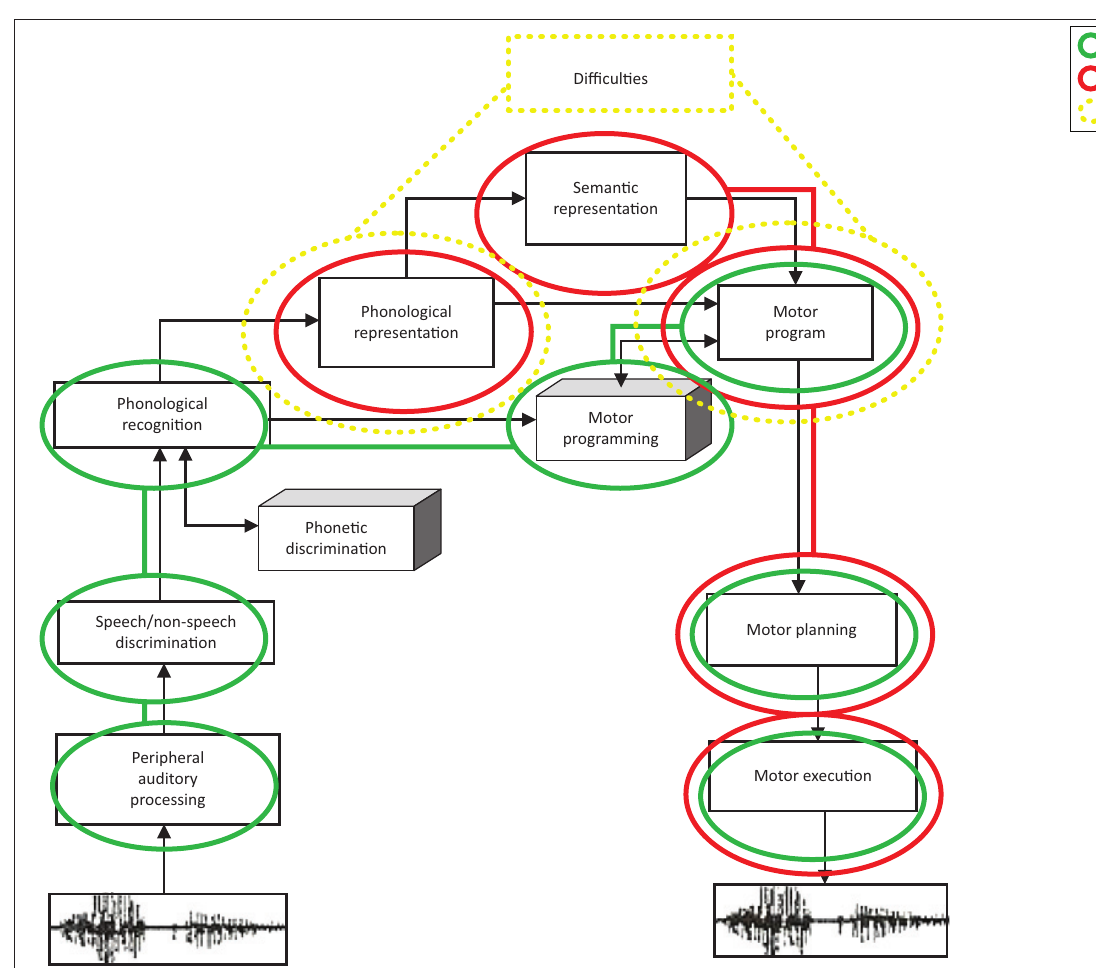
FIGURE 3: Possible areas of difficulty for the word iwotshi [watch] (Child